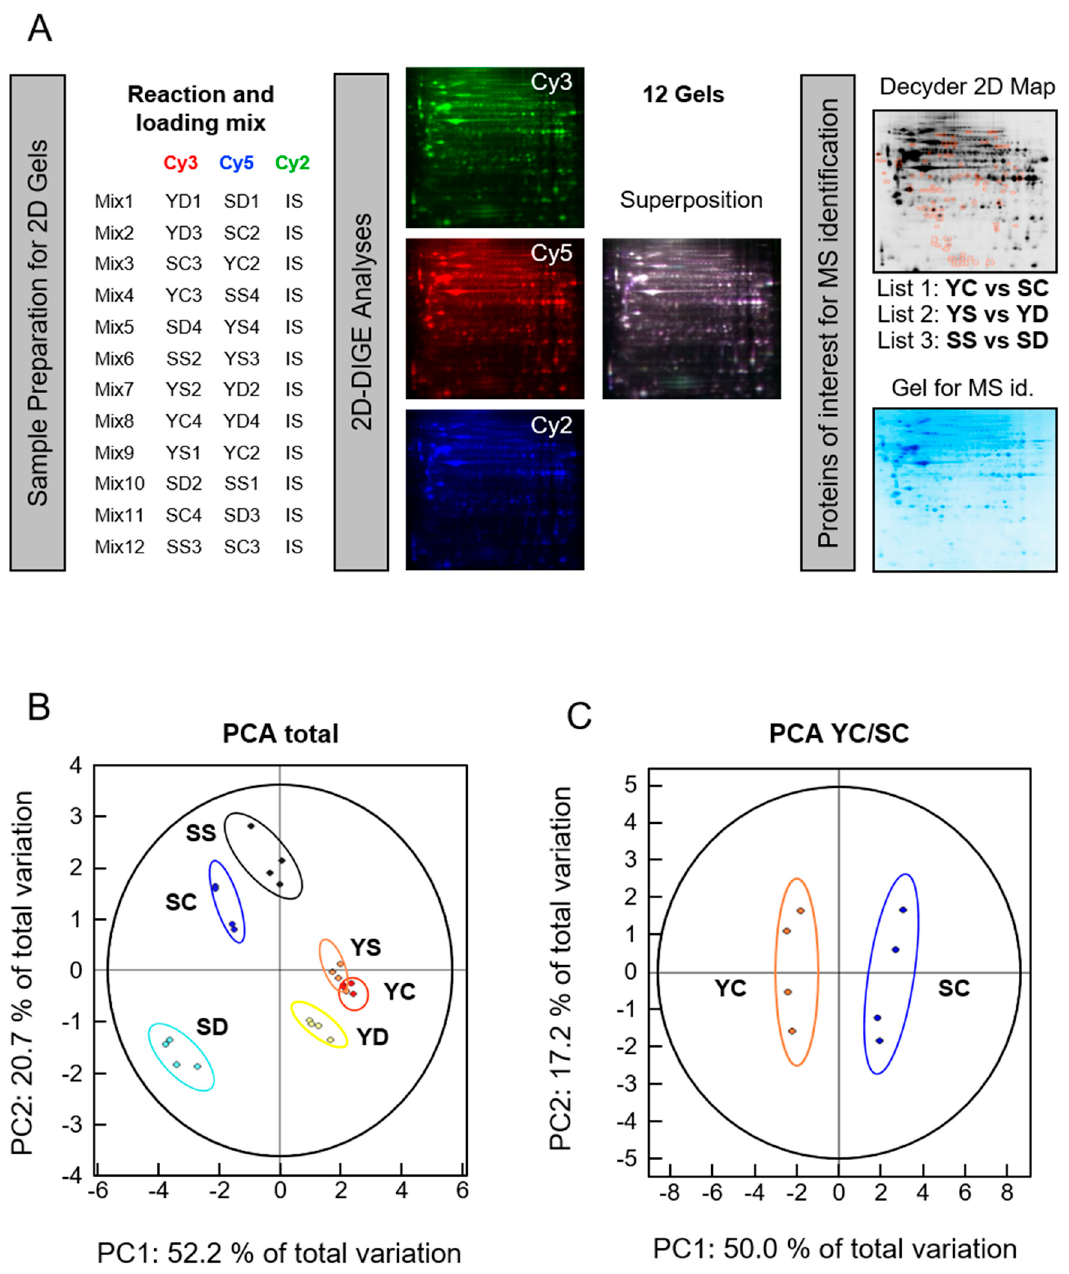
Figure 1. Figure 2. Experimental design and statistical validation of our 2D-DIGE analyses. YD: young Se-depleted; SD: senescent Se-depleted; SC: senescent Se-control; YC: young Se-control; SS: senescent Se-supplemented; YS: young Se-supplemented; MS: mass spectrometry; PCA: principal component analysis; PC1: principal component 1; PC2: principal component